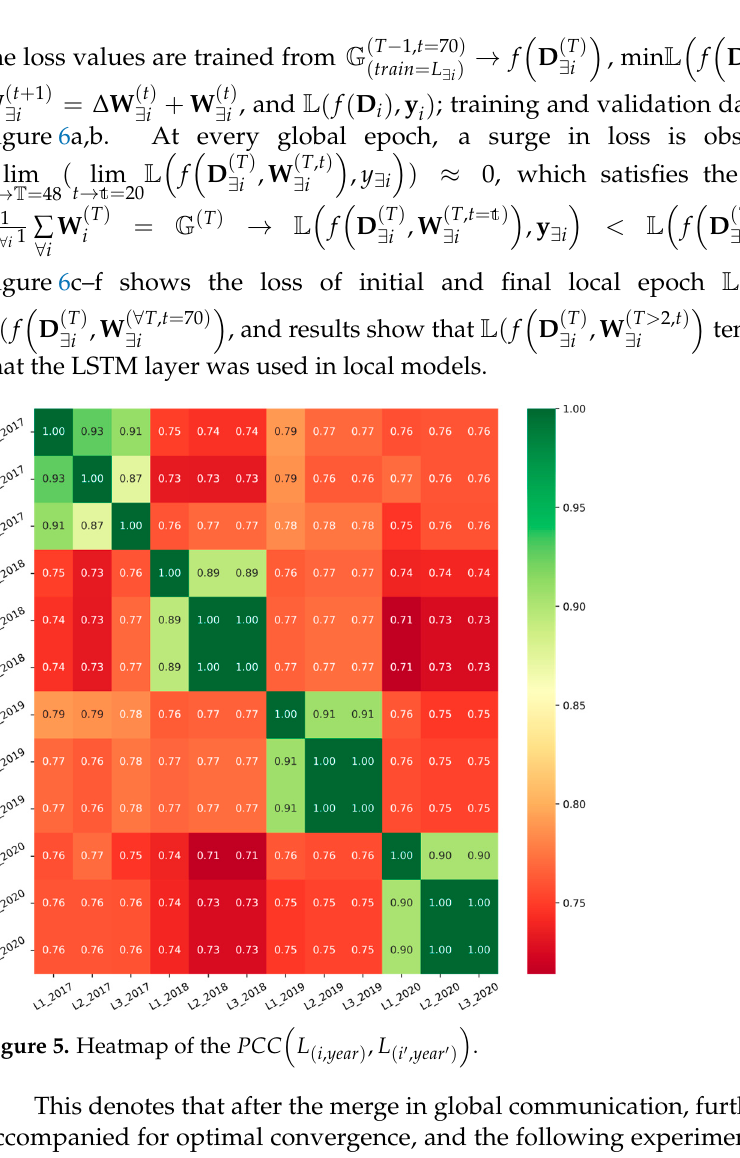
shows the loss of initial and final local epoch 𝕃(𝑓(cid:3435)𝐃 ∃(cid:3036)((cid:3021)) , 𝐖 ∃(cid:3036)(∀(cid:3021),(cid:3047)(cid:2880)(cid:2869)) (cid:3439), 𝕃(𝑓(cid:3435)𝐃 ∃(cid:3036)((cid:3021)) , 𝐖 ∃(cid:3036)(∀(cid:3021),(cid:3047)(cid:2880)(cid:2875)(cid:2868)) (cid:3439) , and results show that 𝕃(𝑓(cid:3435)𝐃 ∃(cid:3036)((cid:3021)) , 𝐖 ∃(cid:3036)((cid:3021)(cid:2997)(cid:2870),(cid:3047)) (cid:3439) tend to converge. Note that the LSTM layer was used in local models.